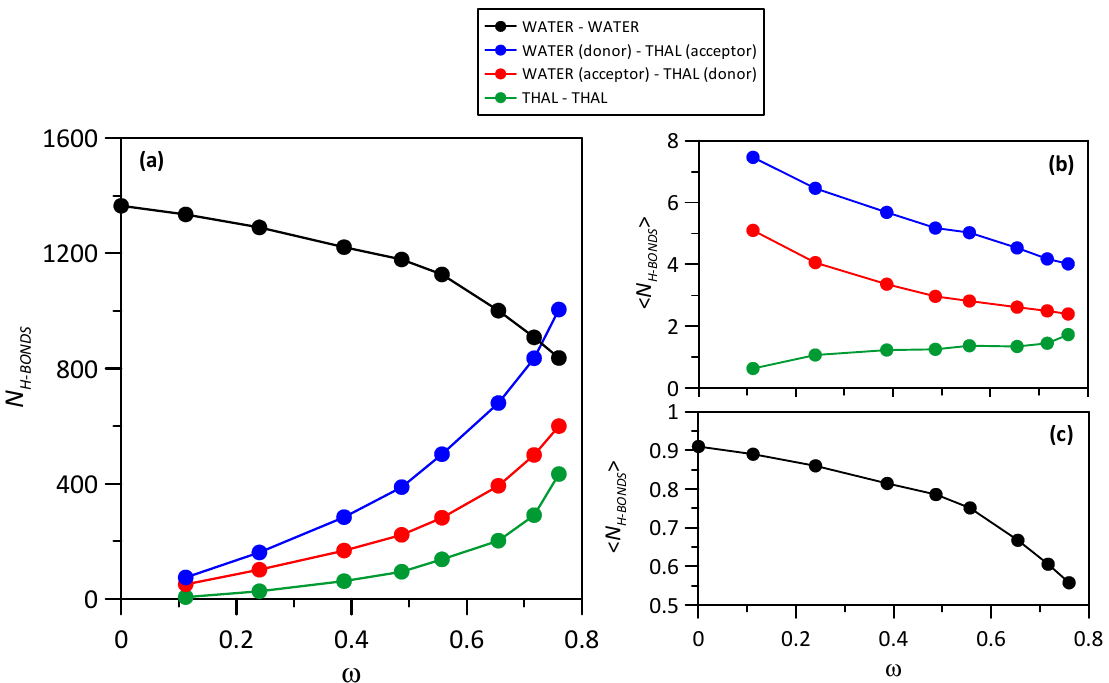
Figure 17. ( a ) Total number of hydrogen bonds in the simulation cell, N H-BONDS , and ( b , c ) number of hydrogen bonds per molecule, < N H-BONDS > , for the reported pairs in ω THAL + (1- ω ) water mixtures ( ω = 0.112) at 310 K. In panel b, results are reported per THAL molecule except for water-water hydrogen bonds.